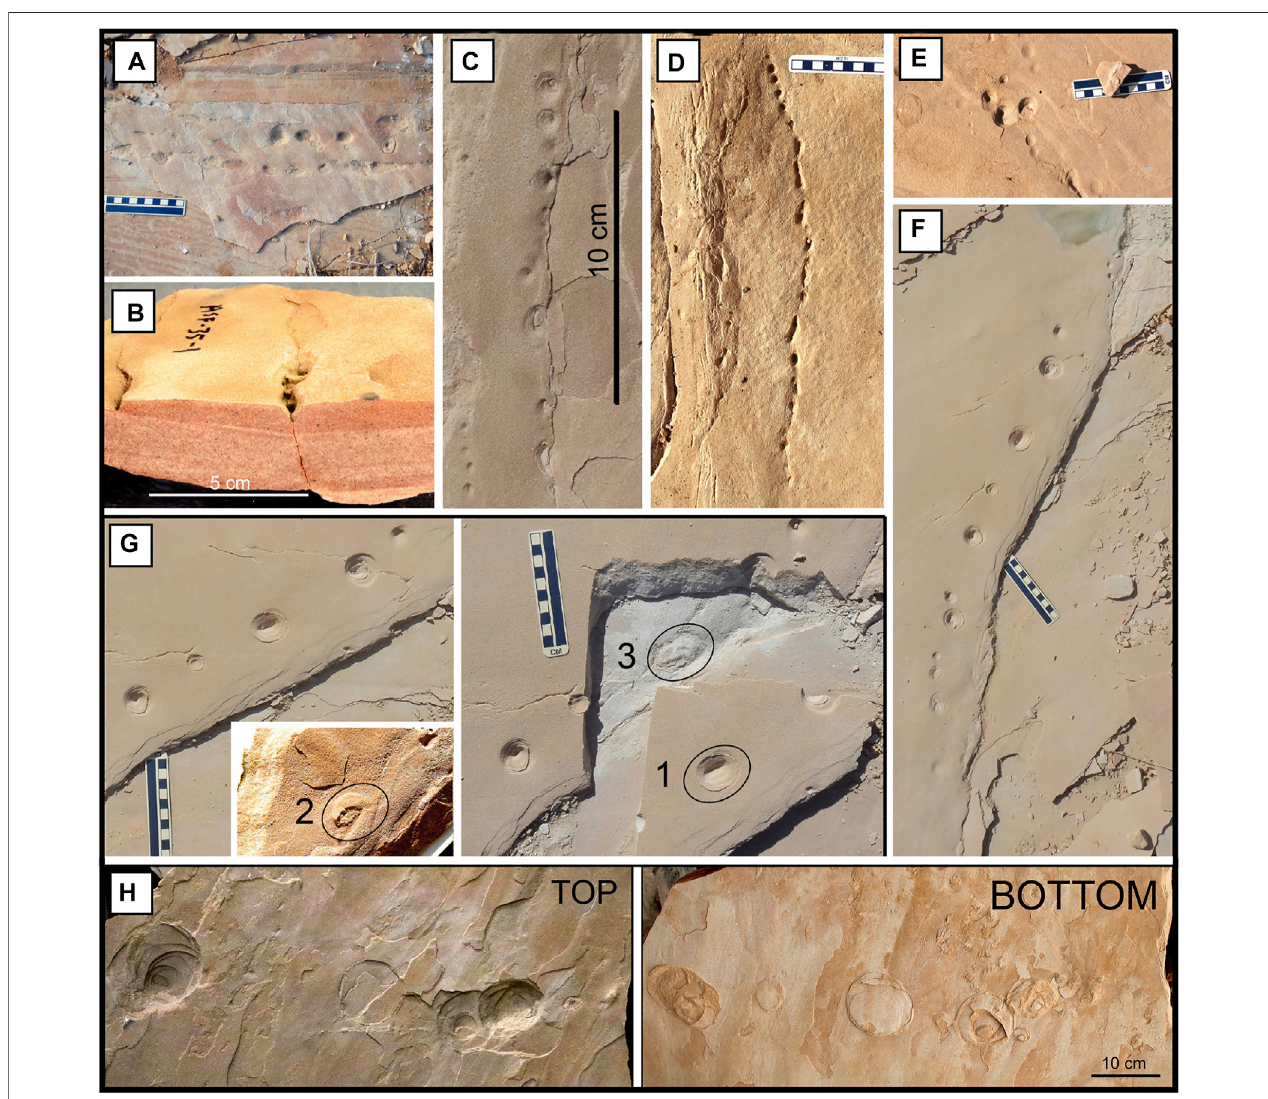
FIGURE11| ConicalpitsassociatedwithSSDSs. (A) Oneoftwogroupsofpitsseenonaboundingsurface.Allothers (C – G) occurwithinornearSSDSsoncross- bedding planes. (B) A cross-section through a row of pits, with a localized crack leading vertically up to the pits. (F,G) These two photos are views of one group of pits, and show thesuccessive surfaces which arepart ofthesame structure.The planviewofonepithas beencircledand annotated witha “ 1. ” The same pitisvisibleon the bottom ofa broken piece from that same bed, 2) and even continues into the underlying layer 3). (H) Structures similar tothe above pits, but much larger. The right photograph has been re fl ected, horizontally, to facilitate comparison of the two sides of the slab, which is 5 cm thick. Cross-beds are dipping toward the bottom of the photos. Scale bars are in cm.